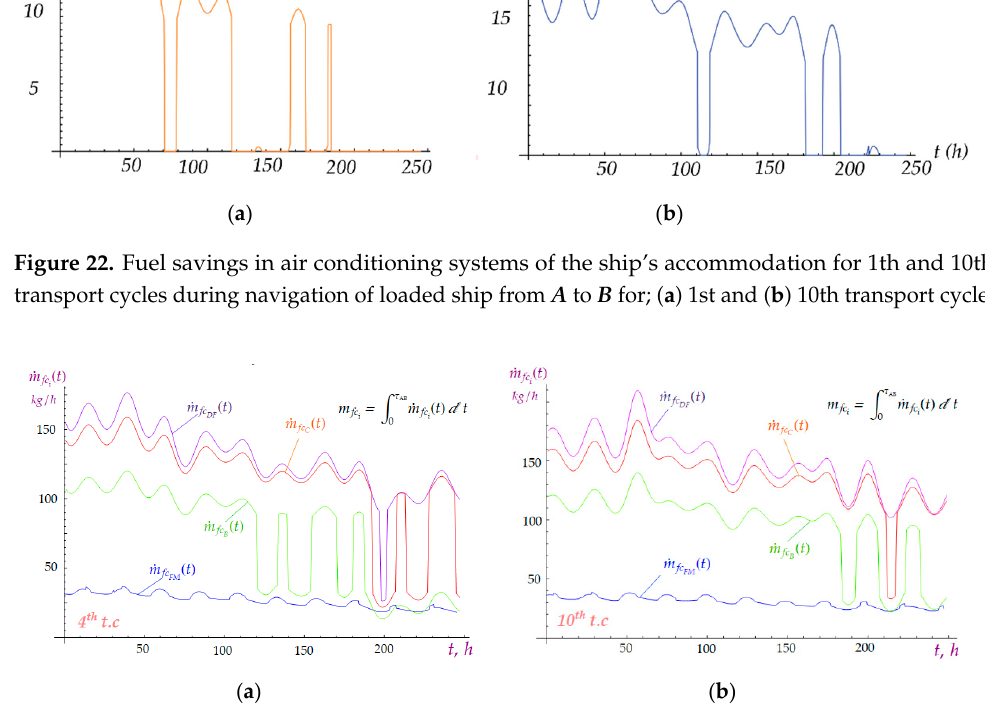
Figure 23. Fuel savings in maintenance of the prescribed microclimate in the storage space for various products during navigation of loaded reefer from A to B for; ( a ) 4th and ( b ) 10th transport cycles.